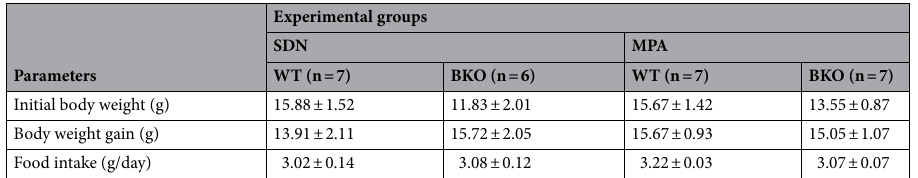
Table 2. Initial body weight of WT and BKO mice, body weight gain and food intake of WT and BKO mice after sedentary (SDN) or mild-intensity physical activity (MPA) periods. Data are mean ± SE. WT wild-type, BKO hemizygous β-globin knockout